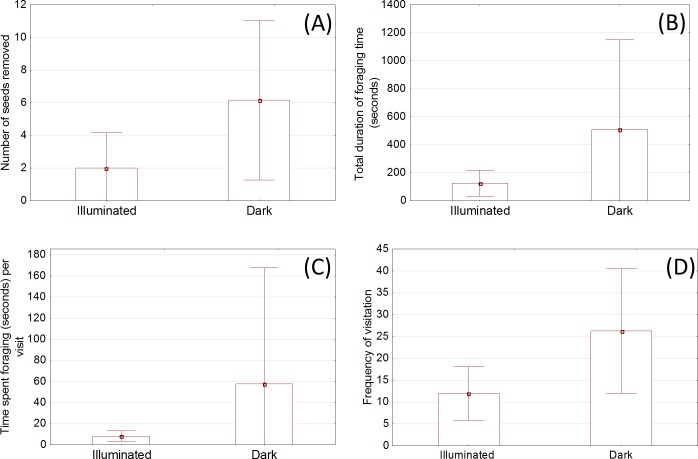
Across pen comparisons (mean with 95% confidence interval) of the: (A) average number of seeds removed from the illuminated area and dark treatment area; (B) total foraging time in the illuminated area and in the dark treated area; (C) time spent foraging per visit at the illuminated area and at the dark treated area; and (D) number of visits to the illuminated area and the dark treated area per 3.5 hour.